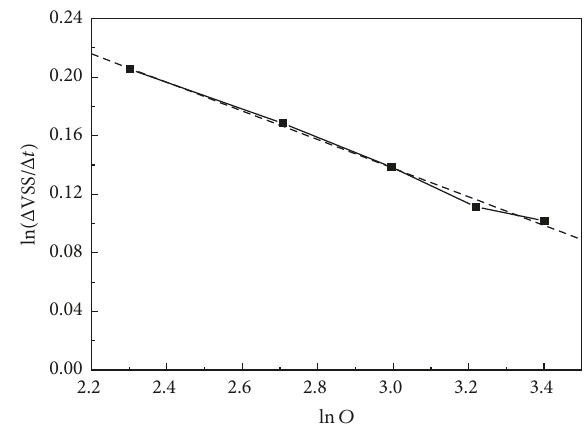
Figure 6: The relationship between ln 𝑘 and 1/ 𝑇 . — ◼ — regression coefficient of 0.9971; ------ ln 𝑘 = 1.2846 − 0.3384/𝑇 .